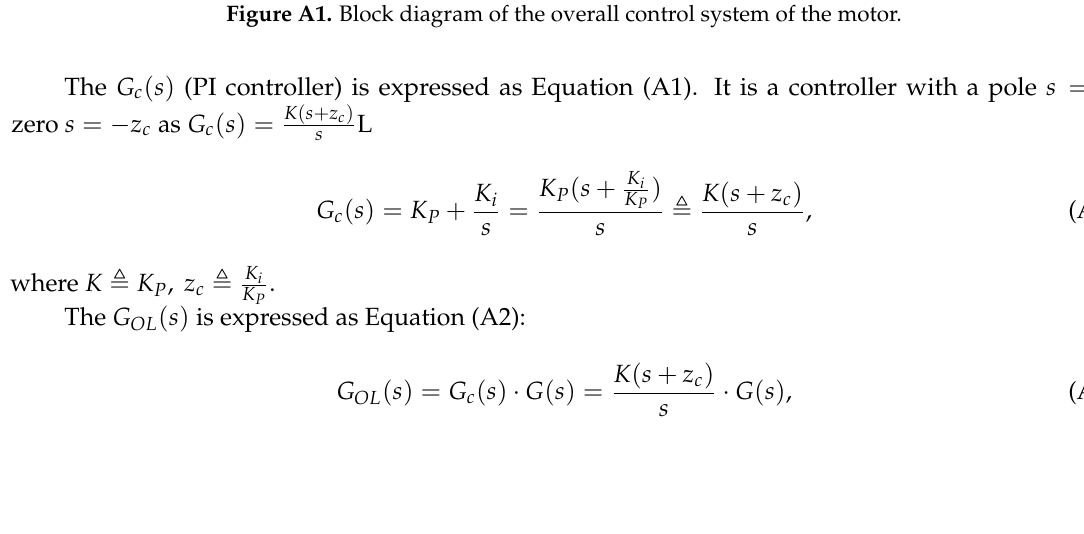
Figure A1. Block diagram of the overall control system of the motor.